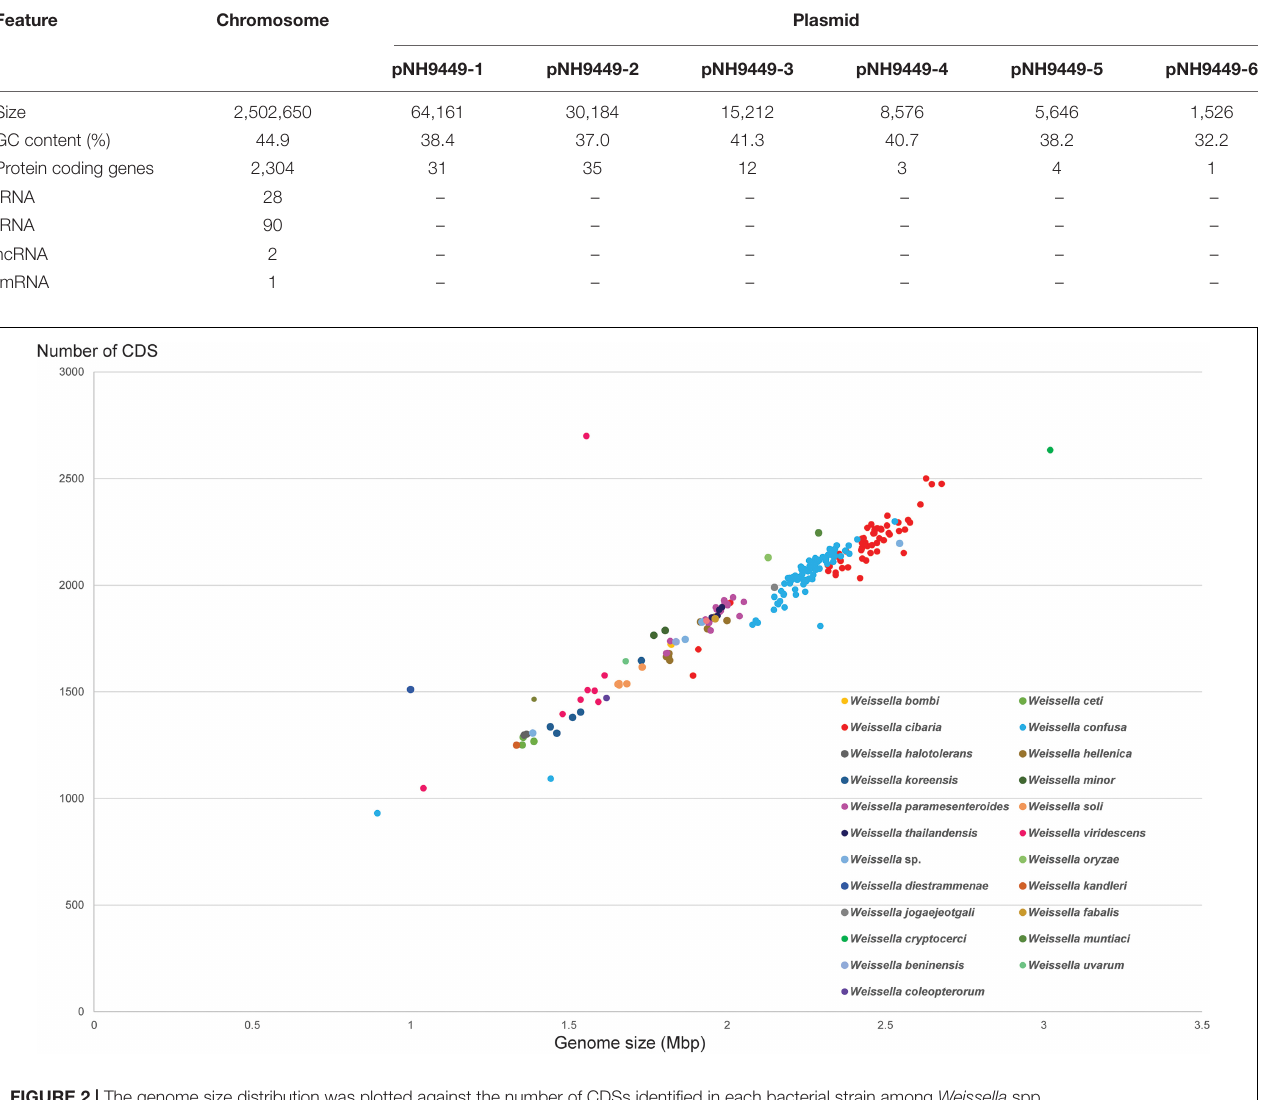
FIGURE 2 | The genome size distribution was plotted against the number of CDSs identified in each bacterial strain among Weissella